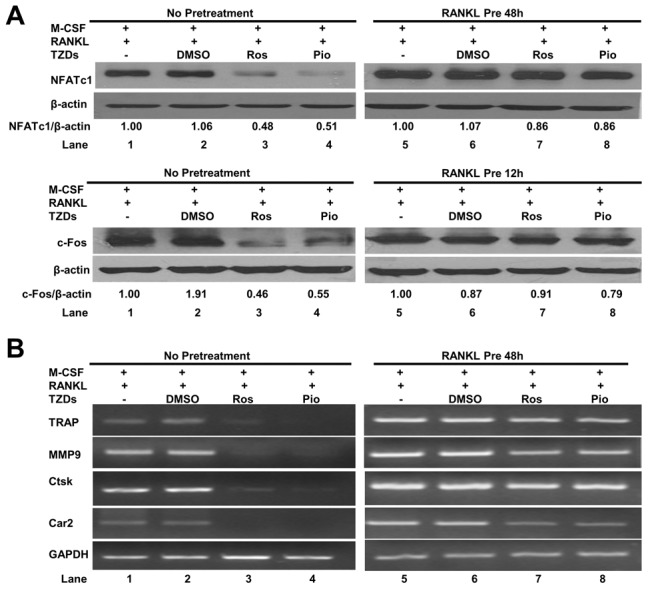
The inhibitory effects of rosiglitazone and pioglitazone on the expression of NFATc1, c-Fos, TRAP, MMP9, Ctsk and Car2 genes are significantly impaired in RANKL-pretreated BMMs.(A) Fresh BMMs (No Pretreatment) or BMMs pretreated with M-CSF (44 ng/ml) and RANKL (100 ng/ml) for 48 h (RANKL Pre 48 h) were treated with M-CSF (44 ng/ml) and RANKL (100 ng/ml), M-CSF (44 ng/ml) and RANKL (100 ng/ml) plus DMSO, 40 µM rosiglitazone (Ros) or pioglitazone (Pio) for 48 hours (h). Cells were then lysed for Western blot analysis of NFATc1 expression. For c-Fos assays, BMMs were pretreated with RANKL for 12 h before culturing with two TZDs for additional 12 h prior to Western blot analysis. The blots were stripped and then re-probed with β-actin antibody for loading control. Ratios of NFATc1/c-Fos to β-actin were obtained by dividing the densitometric reading of NFATc1/c-Fos with that of β-actin, and then the value calculated for the assay treated with M-CSF (44 ng/ml) and RANKL (100 ng/ml) was set as 1.00. The assays were repeated 3 times and the same results were obtained. One typical set of assays is shown. (B) The same set of cultures in A for NFATc1 was repeated for semi-quantitative RT-PCR analysis of the expression of TRAP, MMP9, Ctsk and Car2 genes using GAPDH gene as control. The assays were repeated 3 times and the same results were obtained. One set of assays is shown.